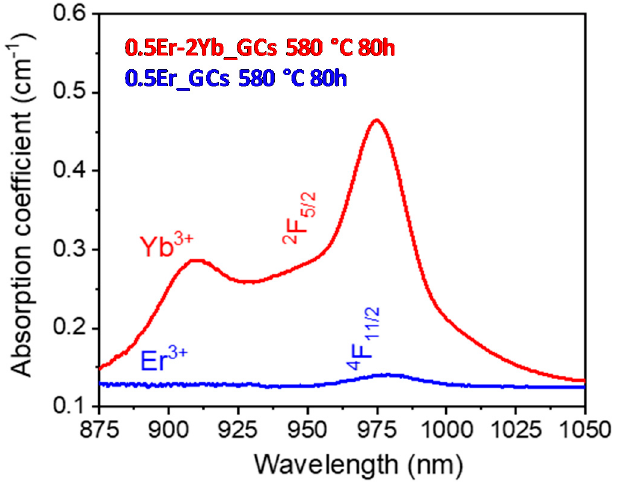
Figure 6. IR-absorption spectra of 0.5Er 3+ and 0.5Er 3+ –2Yb 3+ GCs treated at 580 °C for 80 h. Up-conversion Emission